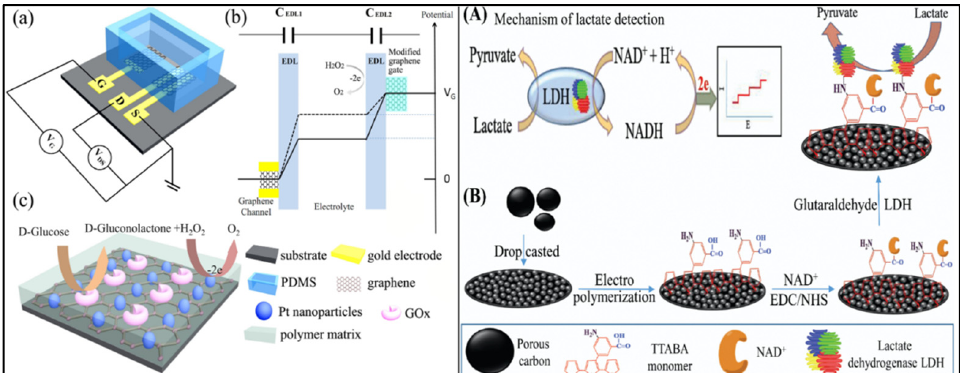
Figure 11. Mechanistic illustration of glucose (left) and lactate (right) detection. On the left, ( a ) schematic representation of a glucose sensor based on solution-gated graphene transistors (SGGT), ( b ) a drop in potential across the two EDLs (electric di-layers), ( c ) the GO-x catalyzed oxidation of glu- cose and oxidation of H 2 O 2 on the electrode of the SGGT. Image reprinted with permission from [160], licensed under http://creativecommons.org/licenses/by-nc-nd/4.0/, accessed on 26 November 2021. On the right, ( A ) schematic illustration of the mechanism of lactate detection and ( B ) the fabrication of a lactate biosensor. Abbr. EDC/NHS (ethyl(dimethylaminopropyl) carbodiimide/ N - Hydroxysuccinimide), TTABA monomer ((poly 3-(((2,2 (cid:48) :5 (cid:48) ,2”-terthiophen)-3 (cid:48) -yl)-5-aminobenzoic acid). Image reprinted with permission from [161] Copyrights (2020),